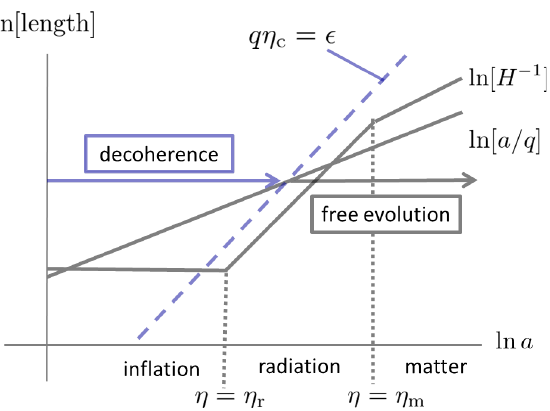
Figure 3. The assumption for the evolution of PGWs. Quantum decoherence continues until η c and then the PGW evolves